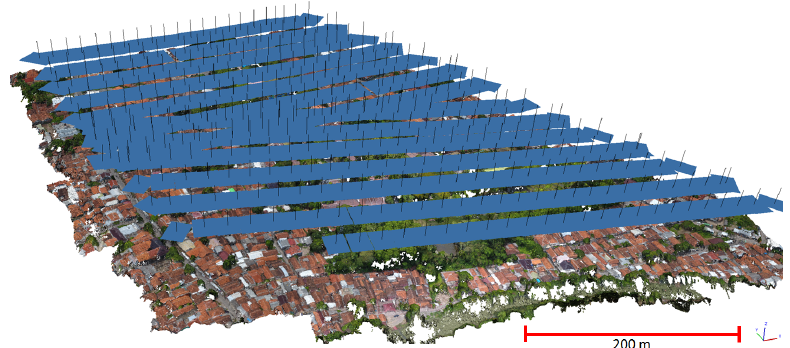
Figure 4. Images of the Step 1 scale level oriented in